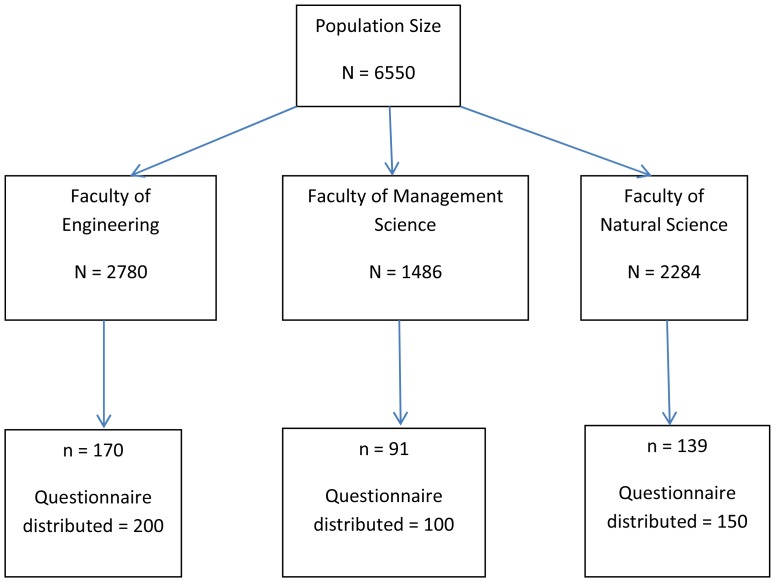
Sample selection.